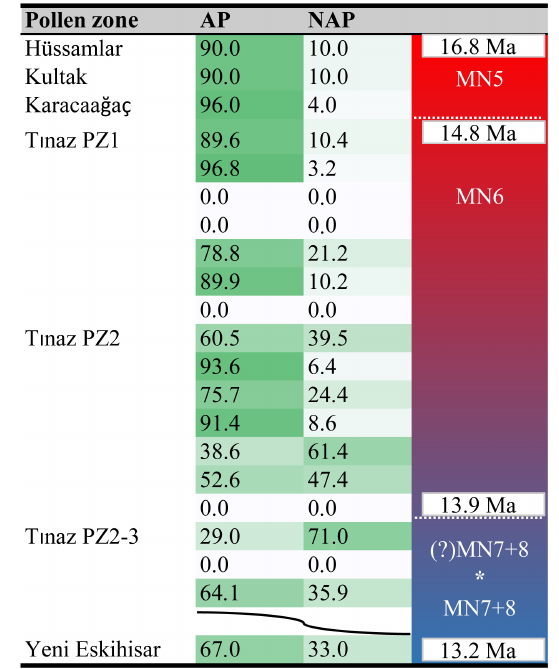
Table 2. Arboreal to non-arboreal pollen ratios in southwestern Anatolia across the MCO, MMCT, and subsequent cooling phase.